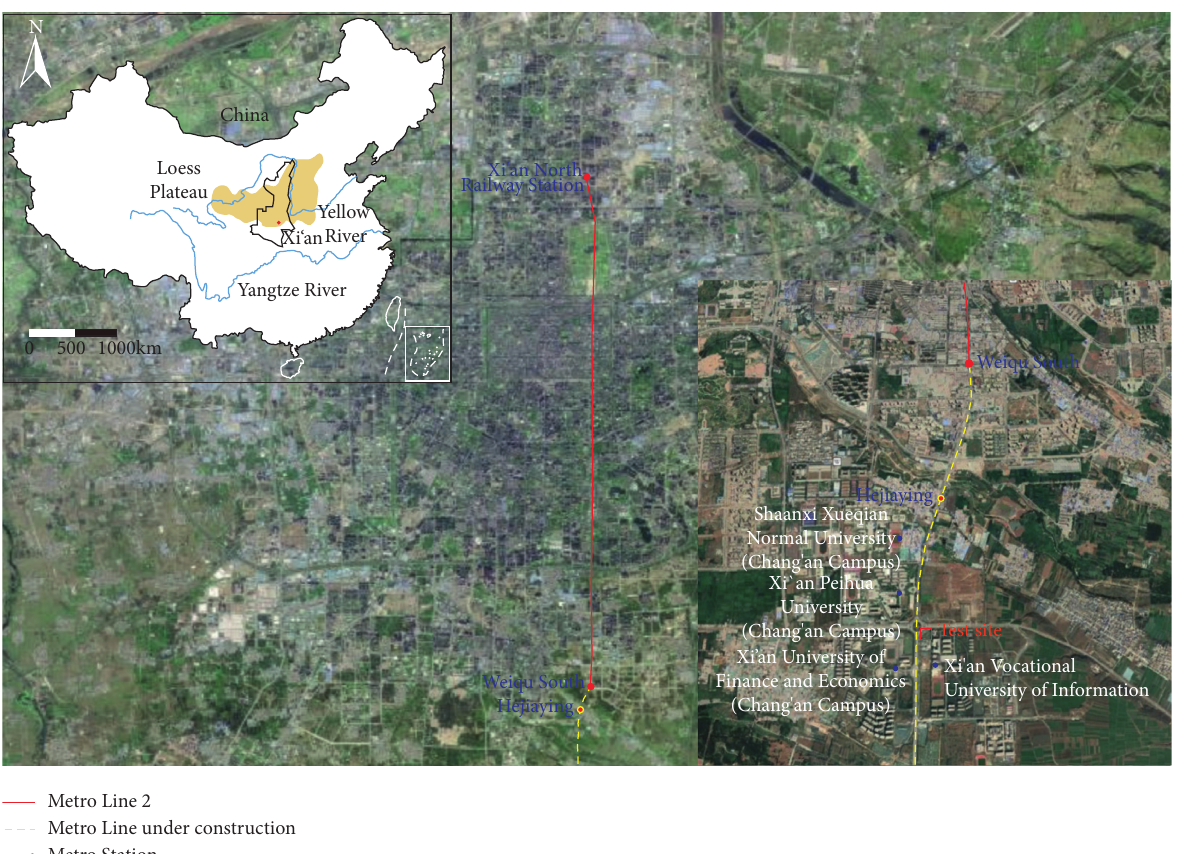
Figure 1: Location of the immersion test site (the map is according to “Xi’an Urban Rail Transit Phase III Construction Plan (2019–2024),”